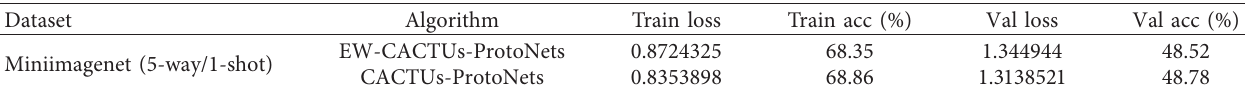
Table 2: Comparisons of the performance of EW-CACTUs-ProtoNets and CACTUs-ProtoNets on Miniimagenet with k � 100 for each